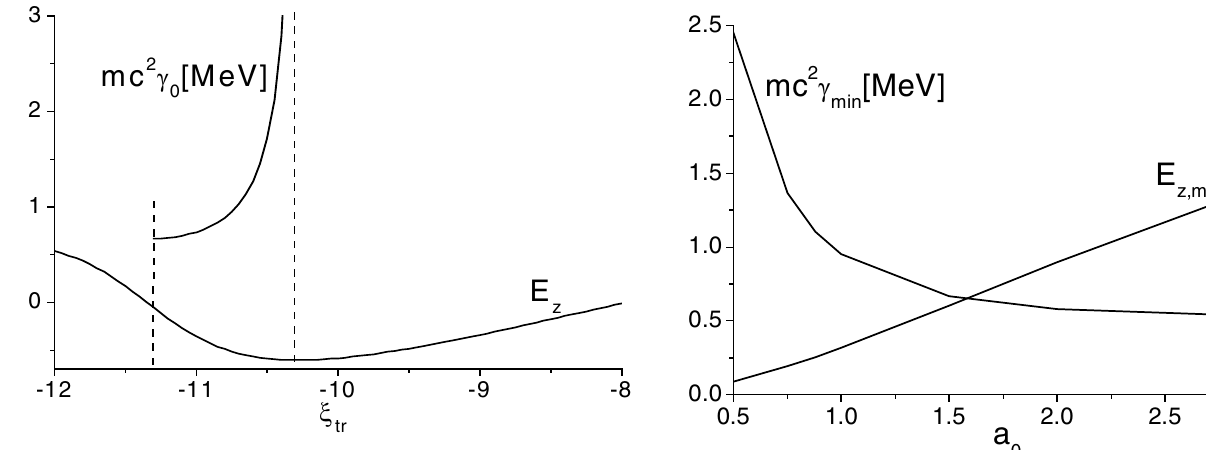
, z; max (cid:2) 50 and ; (cid:6) g 0